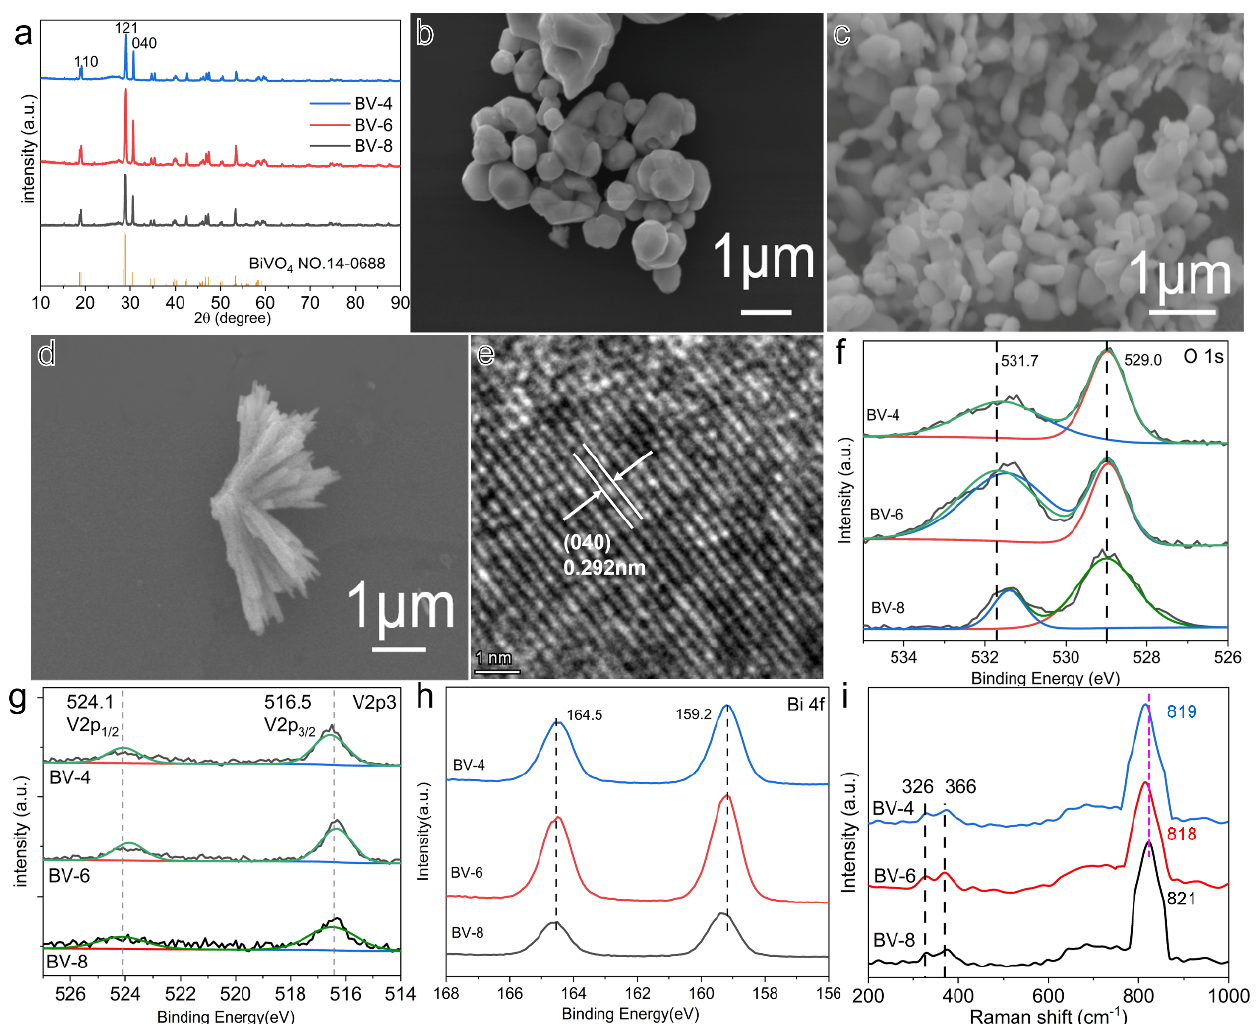
Figure 1. ( a ) XRD patterns of BiVO 4 ; SEM images the of ( b ) BV–4, ( c ) BV–6, and ( d ) BV–8, ( e ) HRTEM image of the BV–6; ( f ) O 1s XPS, ( g ) V 2p XPS, ( h ) Bi 4f XPS spectra, and ( i ) Raman spectra of BiVO 4 .